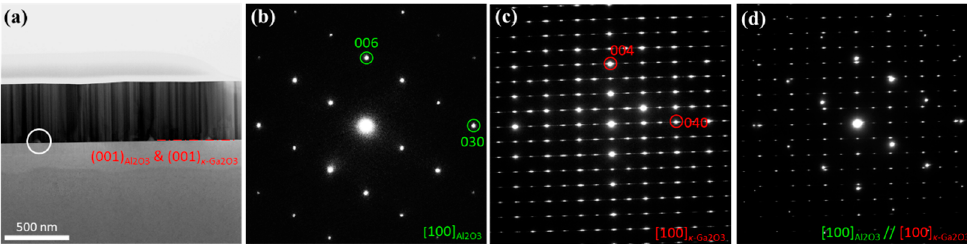
Figure 4. ( a ) Annular bright field (ABF) image showing the general structural feature of the thin film before annealing. Electron diffraction patterns (EDPs) of ( b ) Al 2 O 3 substrate along [100] zone-axis and ( c ) κ -Ga 2 O 3 along [100] zone-axis. ( d ) Composite EDPs of [100] Al2O3 and [100] κ -Ga2O3 taken from the interface. Circled area in ( a ) indicates the hole along the interface.